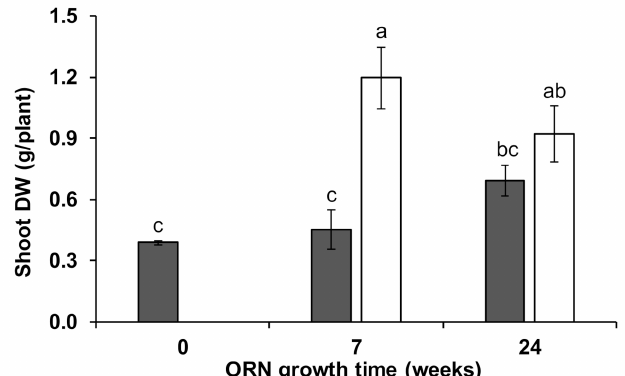
Figure 1. Dry weight (DW, average and standard error) of shoots from wheat plants grown in disturbed (grey columns) or undisturbed (white columns) soil with previously grown Ornithopus compressus (ORN) associated arbuscular mycorrhizal fungi, after 0, 7 or 24 weeks. Differ- ent letters indicate statistically significant differences ( p < 0.05) based on Tukey’s